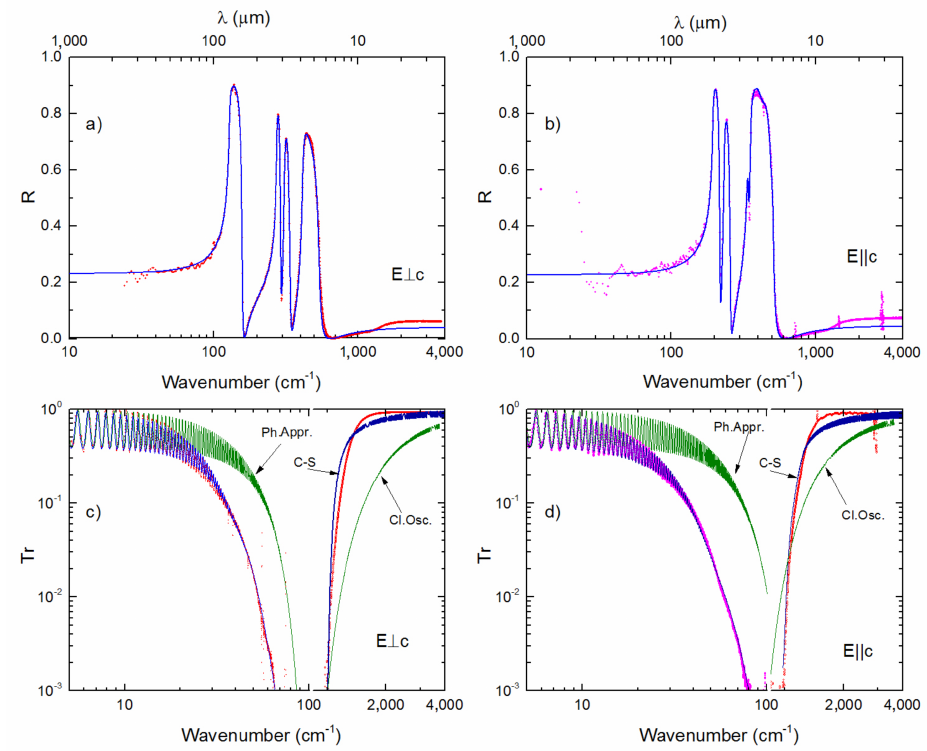
Figure 3. Reflection ( a , b ) and transmission ( c , d ) spectra on the LiGdF 4 single crystal obtained in E ⊥ c and E (cid:107) c. Dots show experimental data. Solid lines show calculated spectra. Lines marked (Ph. Appr.) show extrapolation to the THz range of the calculated spectra in the phonon approximation; lines marked Cl.Osc. are calculated transmission spectra using parameters of classical oscillator model; and lines denoted as C-S show the simulated spectra using Cauchy–Sellmeier approach. Table 1. Parameters of oscillators simulating the absorption bands of the LiGdF 4 single crystal